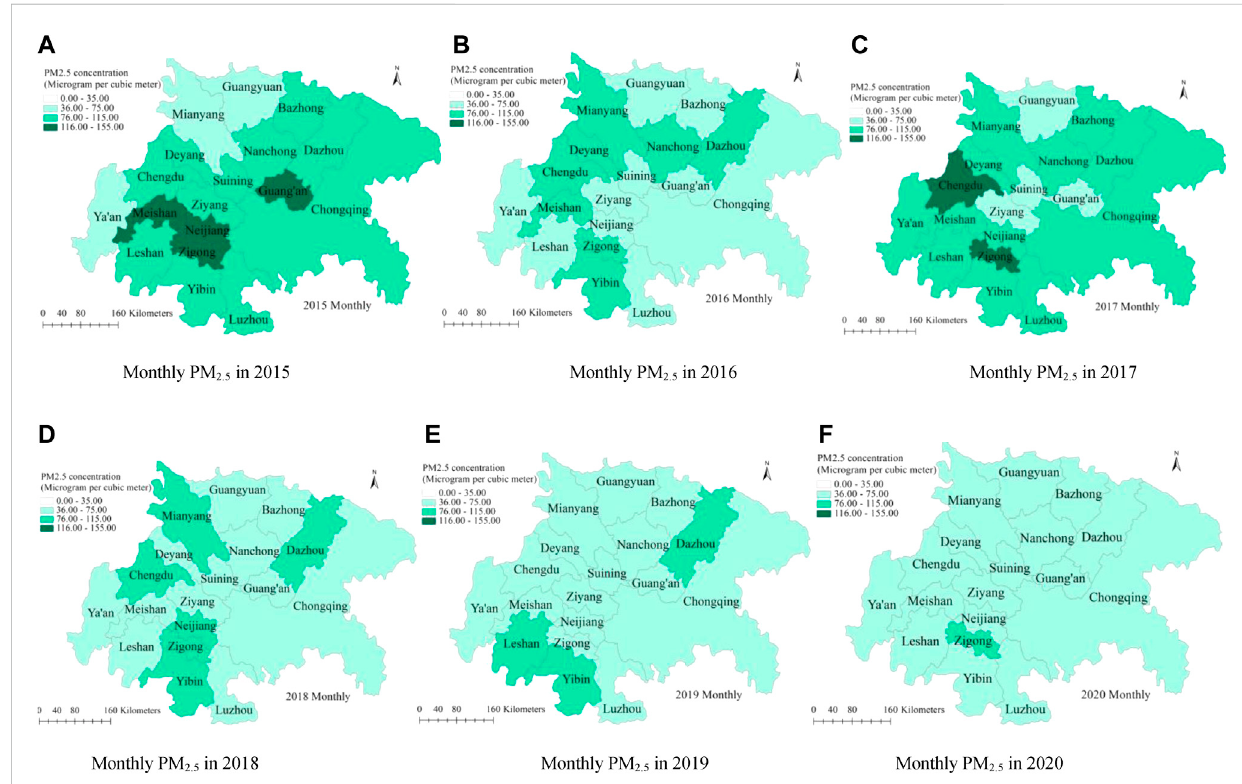
FIGURE 3 PM 2.5 peak monthly concentration (December and January) in SCB 2015-2020. (A) Monthly PM 2.5 in 2015 (B) Monthly PM 2.5 in 2016 (C) Monthly PM